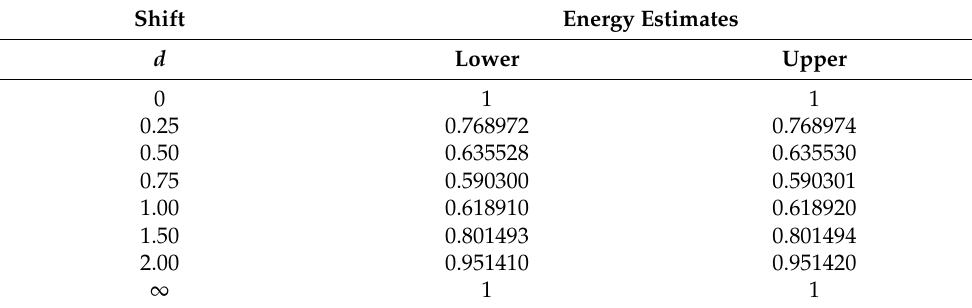
Figure 3. The first three double-well wave functions at d = 3/2. Table 3. The shift-dependence of the ground-state energy. Shift